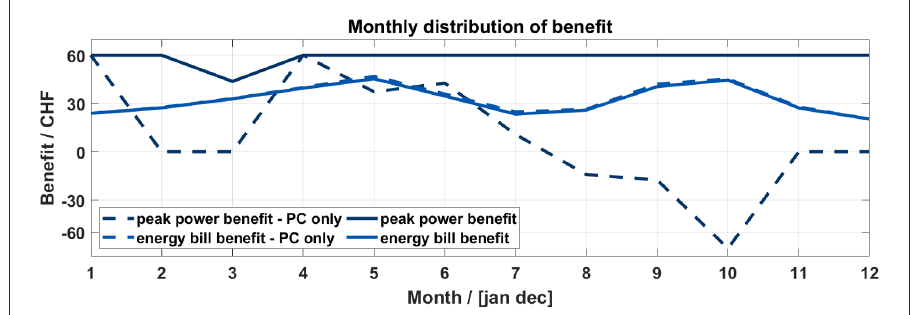
Figure 1 Monthly distribution of bene(cid:12)t